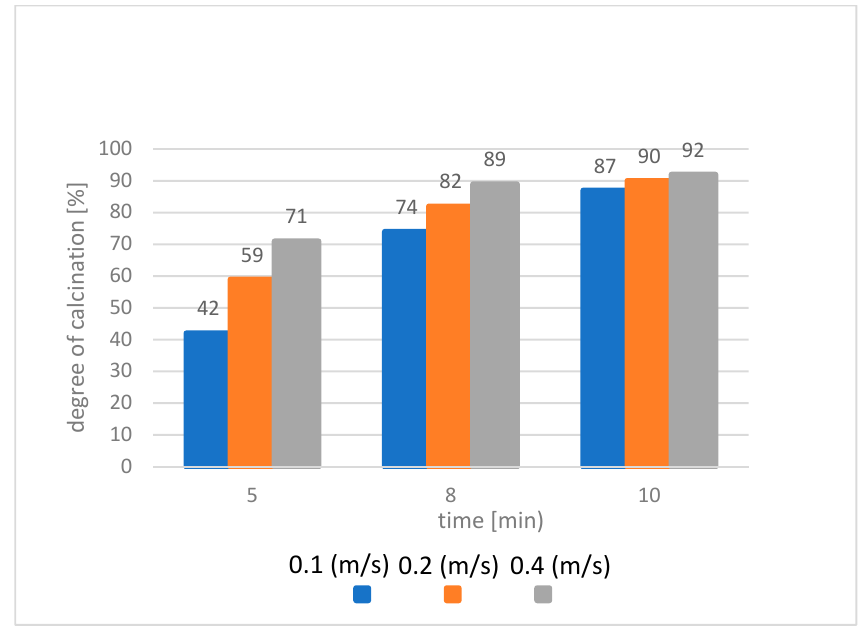
Figure 6. The dependence of the degree of calcination on the time and velocity of fluidization.